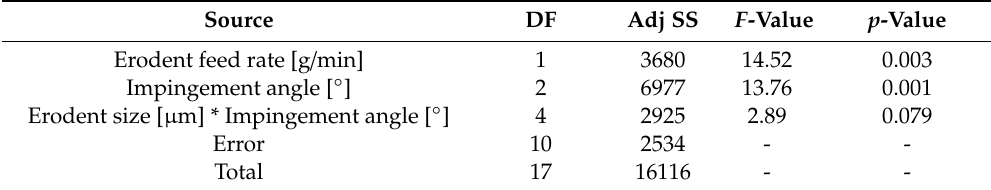
Table 8. Analysis of variance (ANOVA) after the stepwise regression for the Erosion rate [mg/min], with an indication of the source of variation, degrees of freedom (DF), Adjusted Sum of Squares (Adj SS), F -value, and p -value [35].